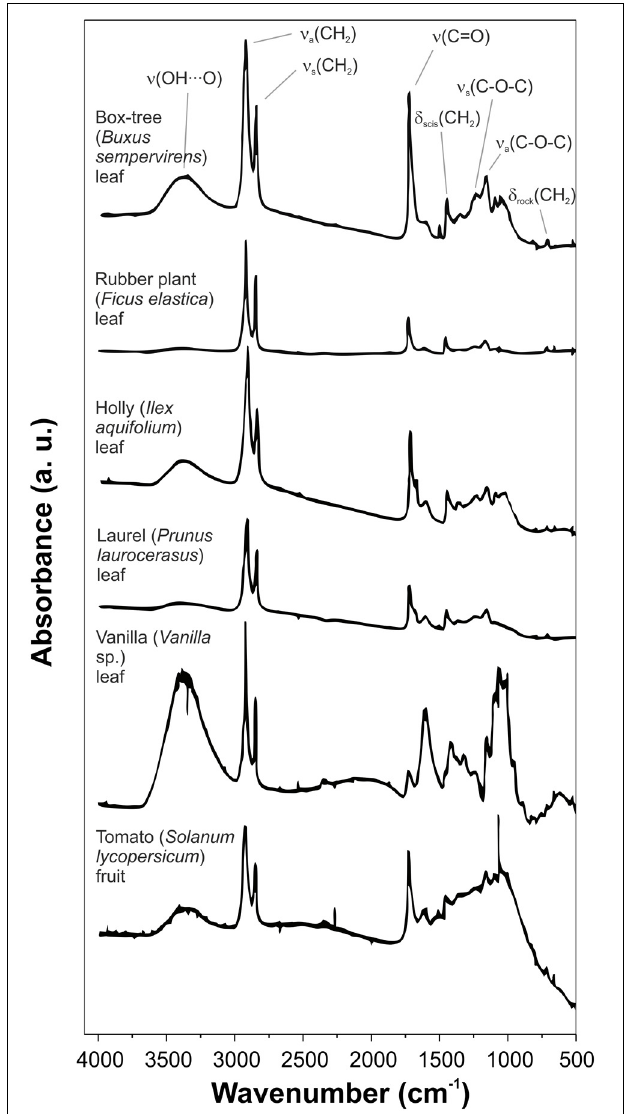
FIGURE 2 | Transmission FTIR spectra of isolated cuticles of different plant species. Some main bands are assigned. Adapted from Chamel and Maréchal